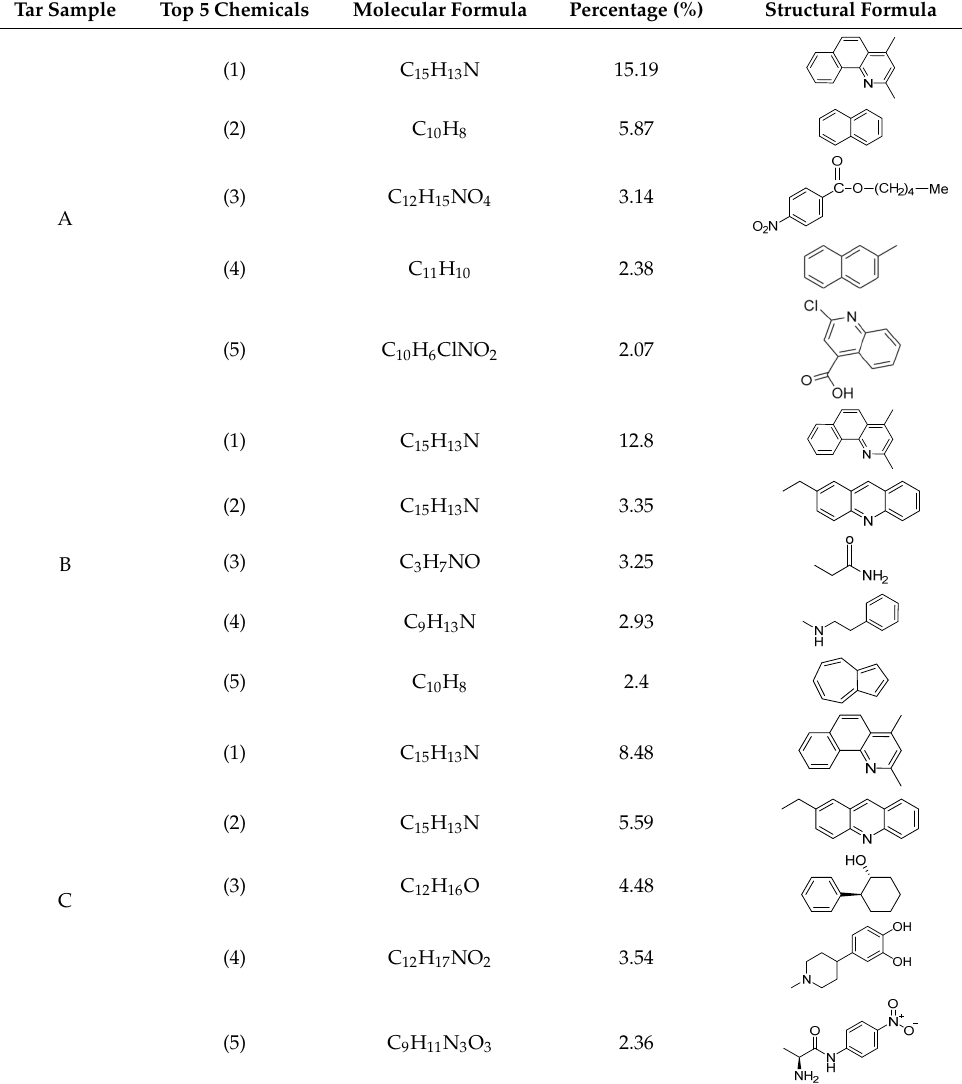
Table 1. Top five chemicals in different tar samples.